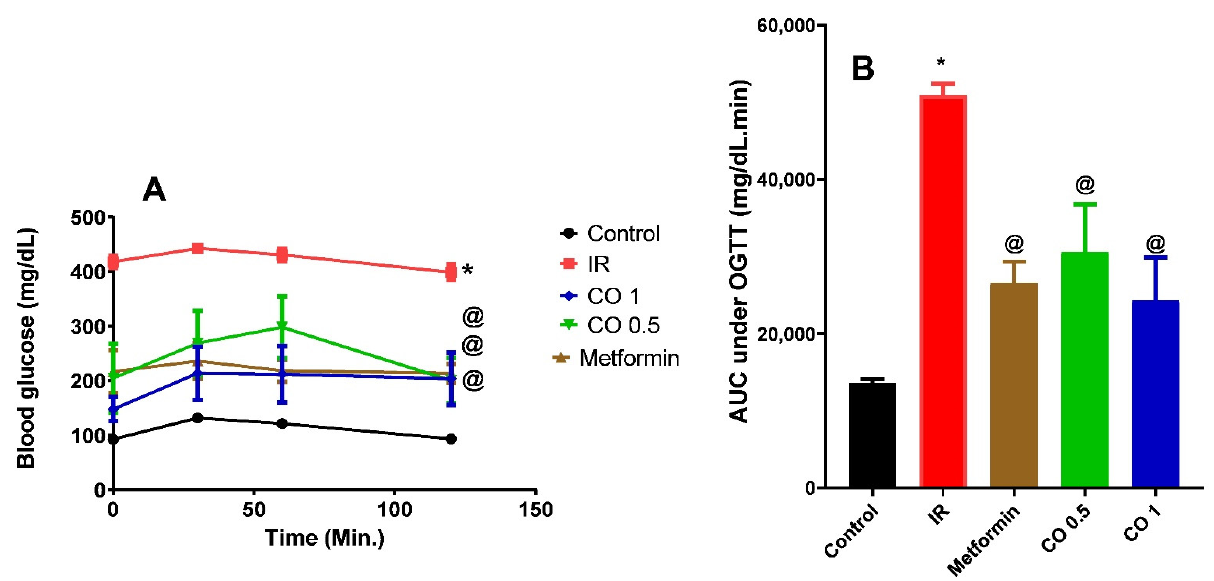
Figure 1. Effect of coriander oil (CO, 0.5 and 1 mL/kg, PO) and metformin (50 mg/kg/day, PO) on body weight ( A ), weight of pancreas ( B ), organ index of pancreas ( C ) in dexamethasone-induced insulin resistance in rats (IR). Results were analyzed by one-way ANOVA followed by the Post-hoc Tukey test. Results are shown in mean ± SEM ( n = 6). * , @, # p < 0.05 compared to normal, IR, and metformin groups, respectively.